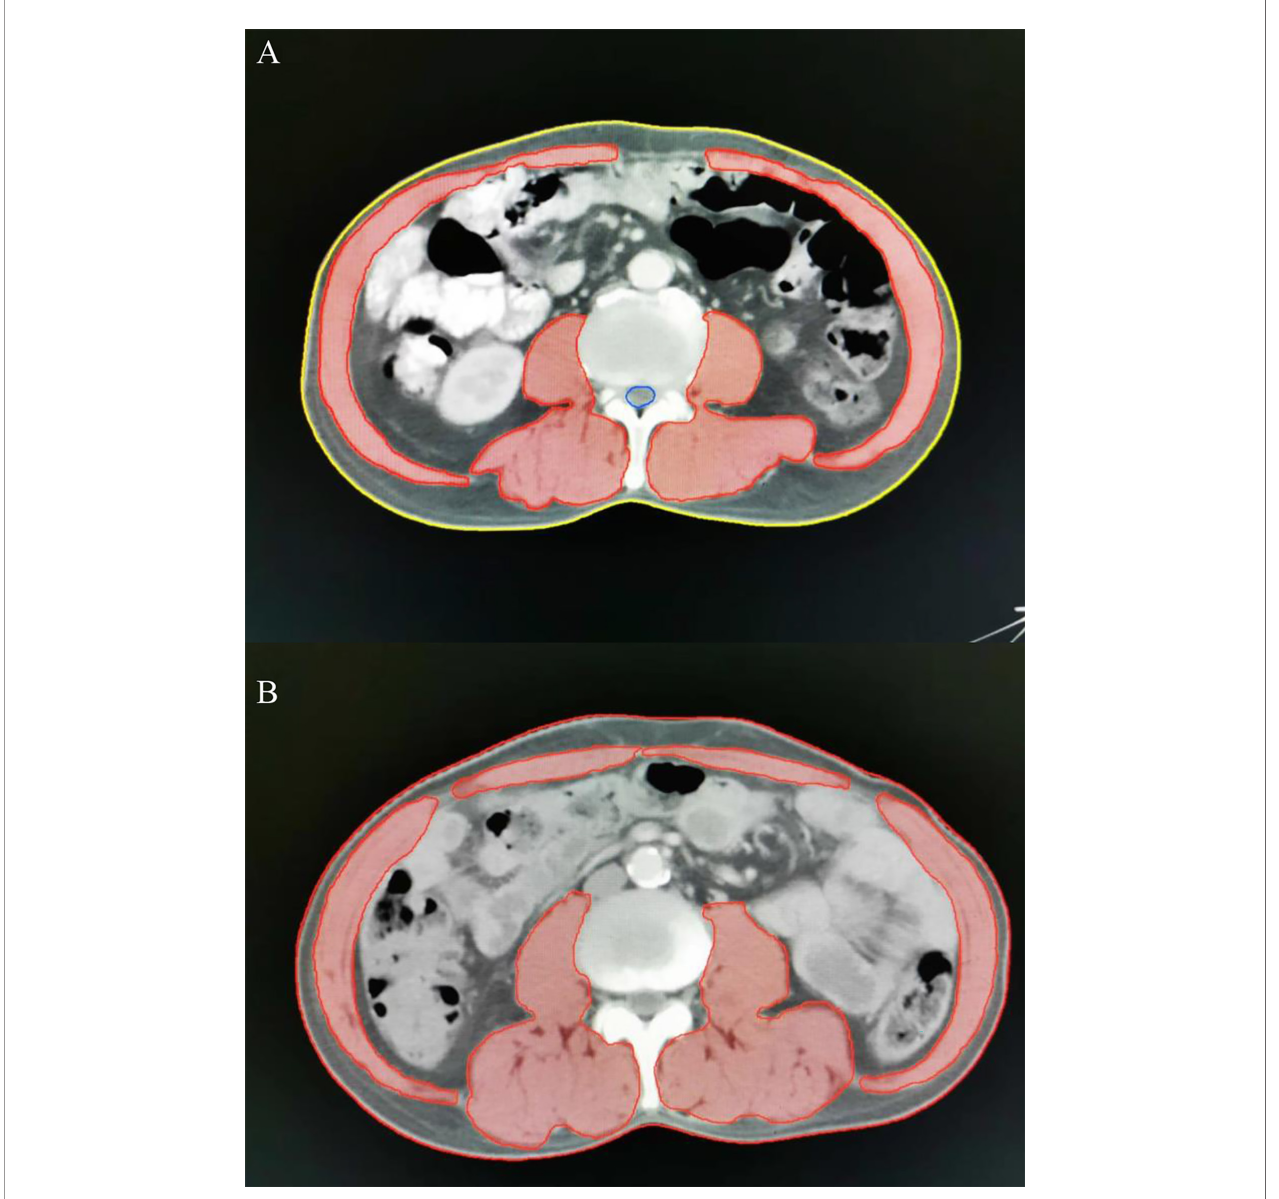
FIGURE 1 | Axial computed tomography (CT) images at the level of L3 with skeletal muscle highlighted in red. Representative CT images in patients with ( A , a-67-year-old male patient, SMA =122.85 cm 2 , BMI = 21.38 kg/m 2 , SMI=41.04 cm 2 /m 2 ) and without sarcopenia ( B , a-62-year-old male patient, SMA =158.64 cm 2 , BMI = 21.51 kg/m 2 , SMI=56.88 cm 2 /m 2 ). SMA, skeletal muscle area; BMI, body mass index; SMI, skeletal muscle